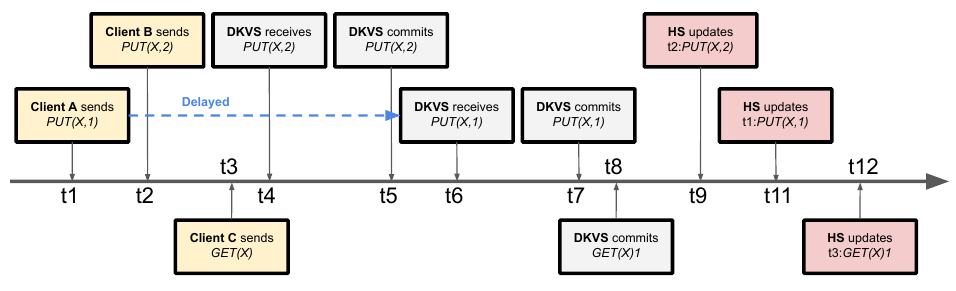
Figure 5. Commit Out-of-Order